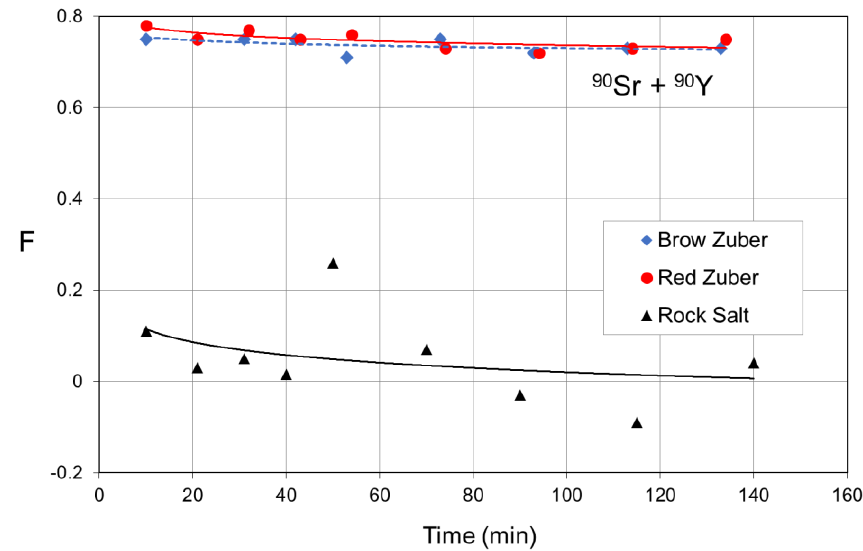
Figure 10. Sorption of the 90 Sr + 90 Y isotope of the Brown and Red Zuber unit samples and rock salt samples (according to [56]).